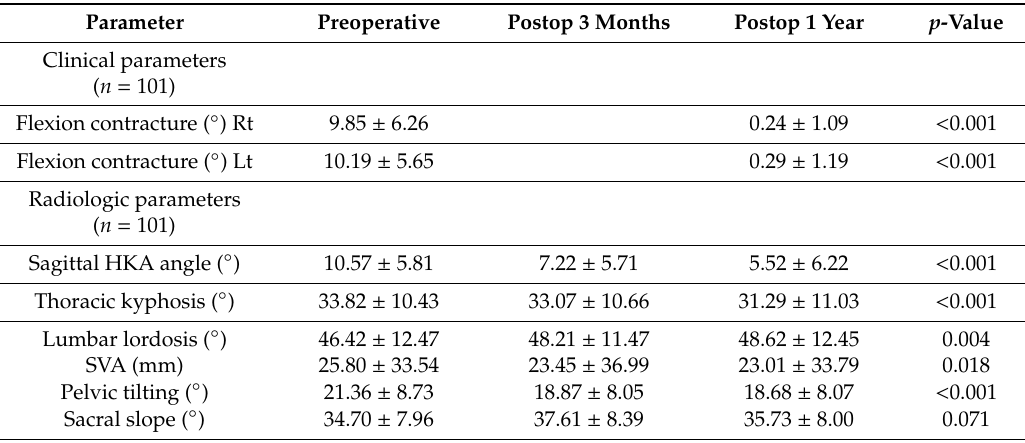
Table 1. Data of all sagittal parameters.